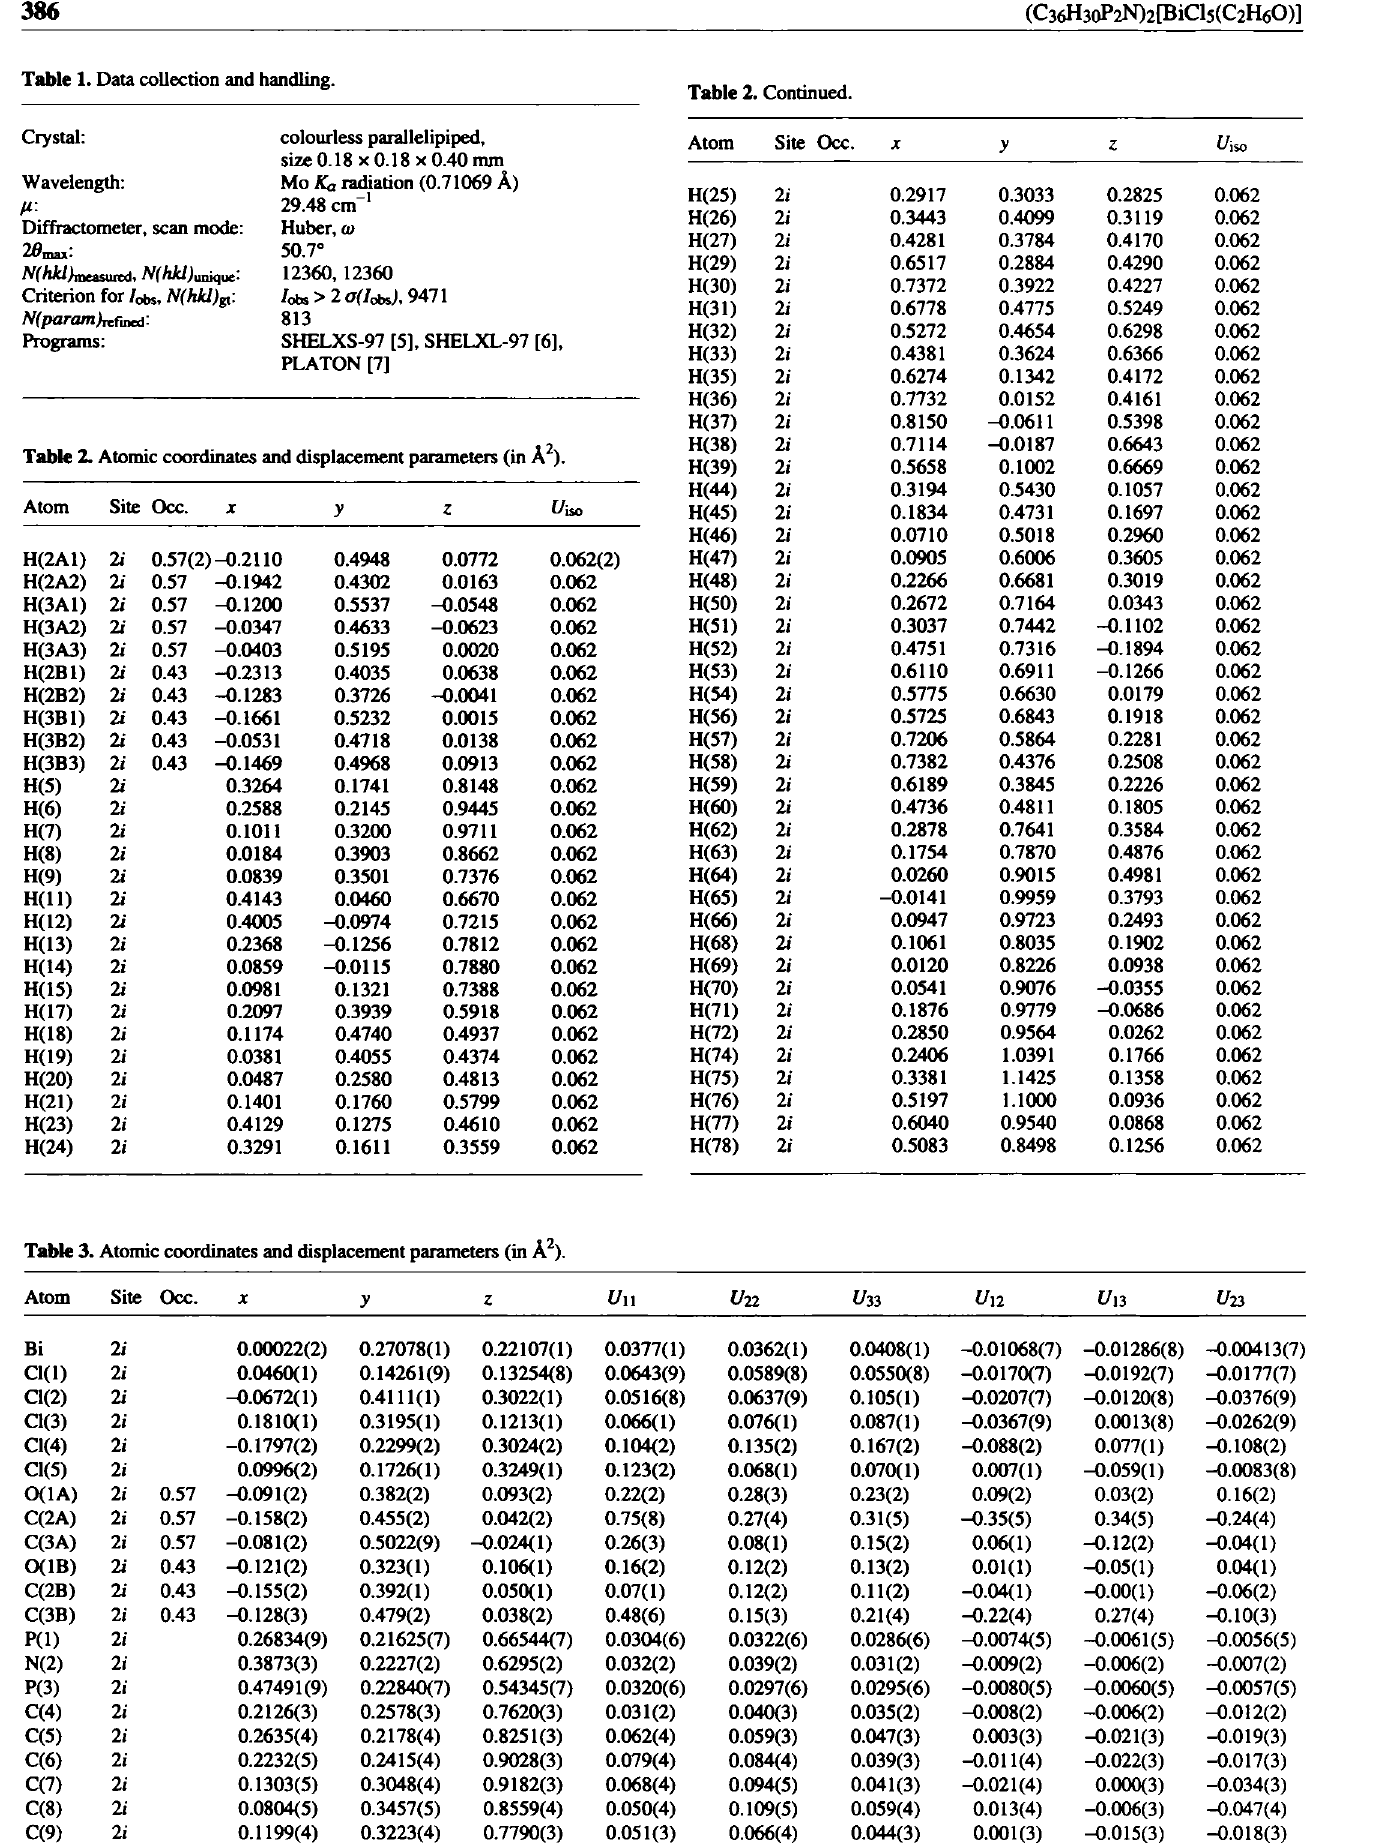
Table 2. Atomic coordinates and displacement parameters (in À 2 ).